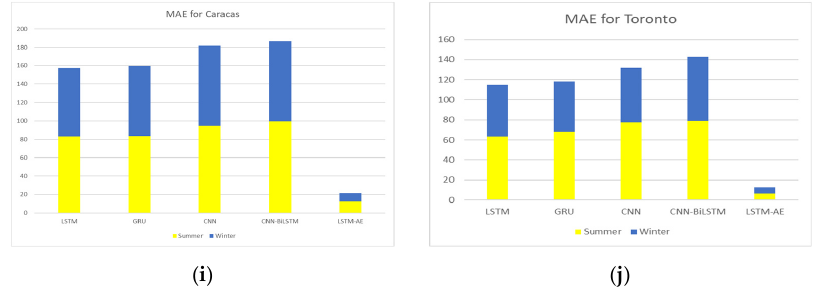
Figure 29. MAE of summer vs. winter for 5 models for: ( a ) Al-Baha; ( b ) Al-Jouf; ( c ) Al-Khafji; ( d ) Arar; ( e ) Hail; ( f ) Tabuk; ( g ) Taif; ( h ) Wadi-Addwasir; ( i ) Caracas; ( j ) Toronto.